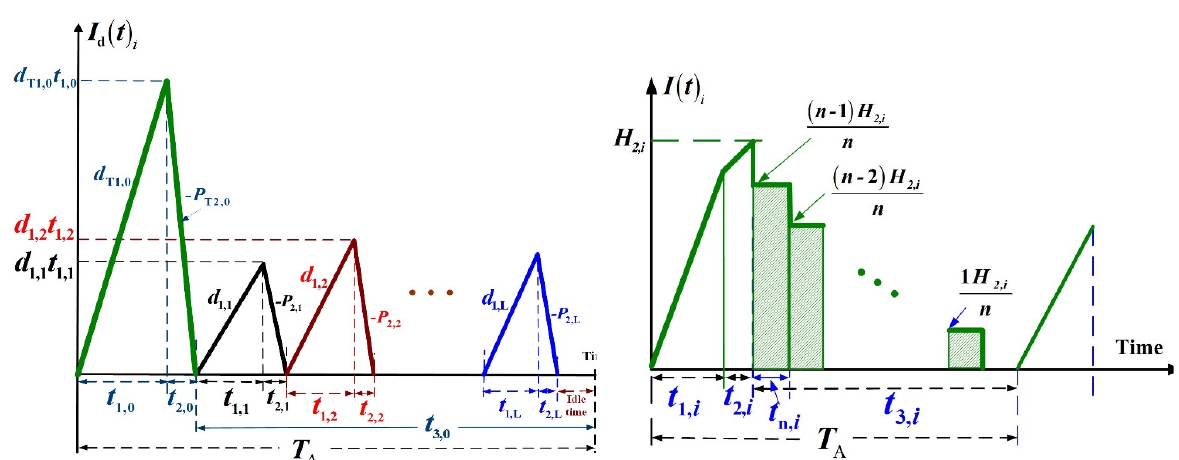
Fig. 2. This study’s nonconforming inventory level Fig. 3. End product i ’s inventory level in t 3, i